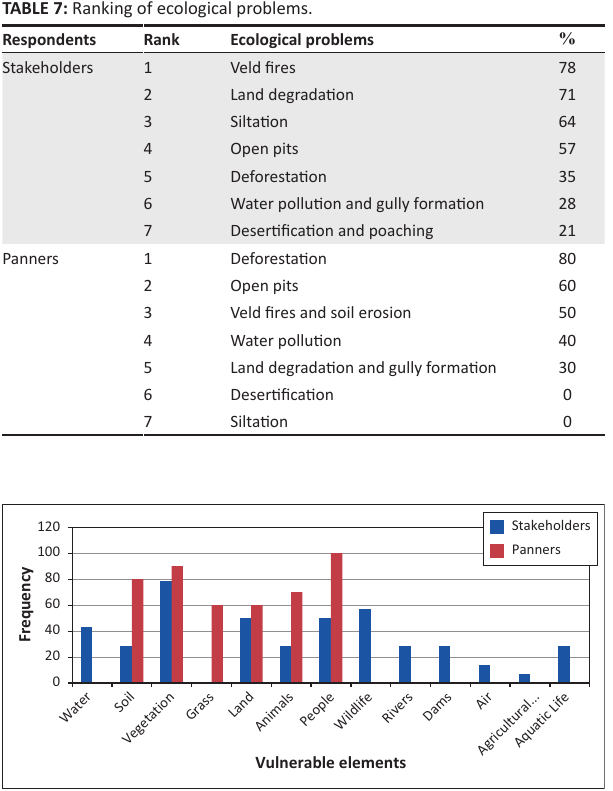
FIGURE 9: Vulnerable elements in Mzingwane District identified by respondents. TABLE 8: Mitigation strategies in Mzingwane. Mitigation strategies